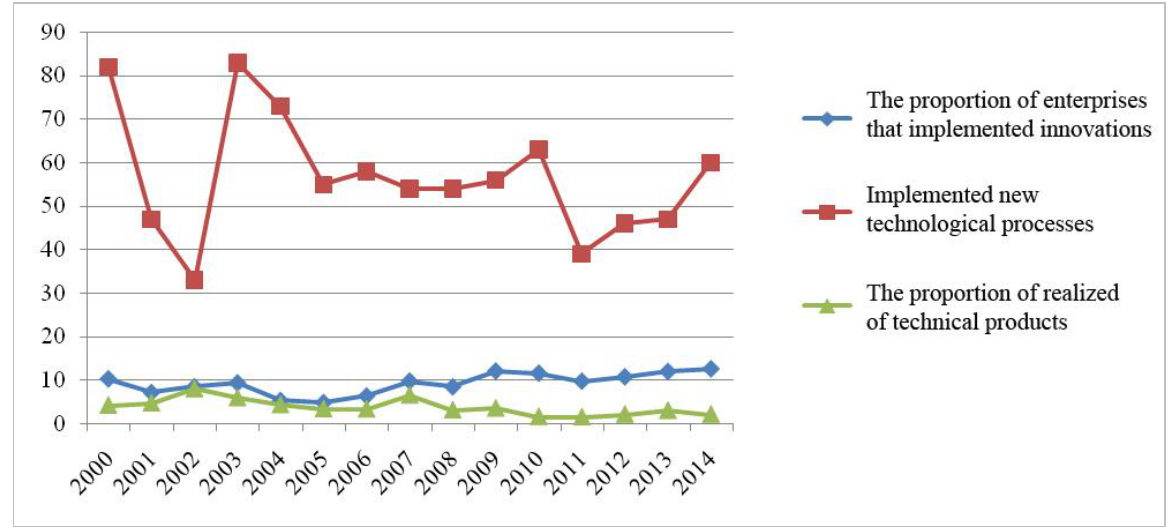
Fig. 3. Dynamics of innovations implementation in enterprises of Lviv Region for the period of 2000-2014. Processed on the basis of the data from Main Department of Statistics of Lviv